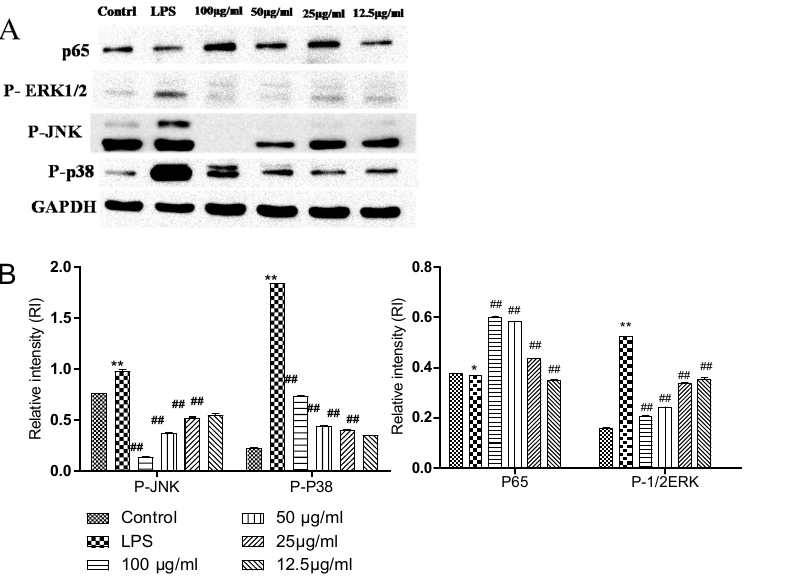
Figure 4. Effects of different concentrations of GF:OA = 1:9 on the proteins expression of P-p65 in NF- κ B signaling pathway in LPS-induced RAW 264.7 cells. Effects of different concentrations of GF:OA = 1:9 on the proteins expression of P-JNK, P-p38 α , and P-ERK1/2 in MAPK signaling pathway in LPS induced RAW 264.7 cells. Cells were pretreated with GF:OA = 1:9 (12.5, 25, 50, and 100 µ g/mL) for 1 h, followed by LPS (1 µ g/mL) stimulation for 24 h. The protein expression was determined by Western blot analysis, and GAPDH served as an internal control ( A ). Values represent the mean ± SD of the three independent experiments (* compared with the control, # compared with LPS, * p ≤ 0.05, and **/## p ≤ 0 01) ( B ).